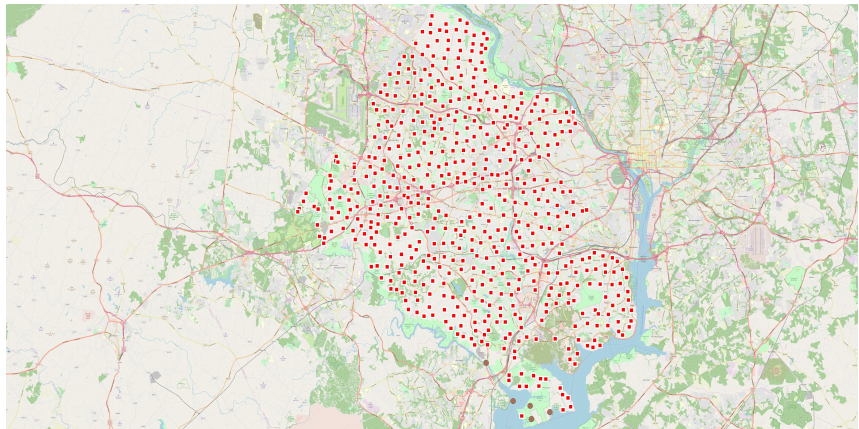
Figure 16. Point-cluster analysis where points are represented by brown circles and clusters by red squares signify the households over the region.